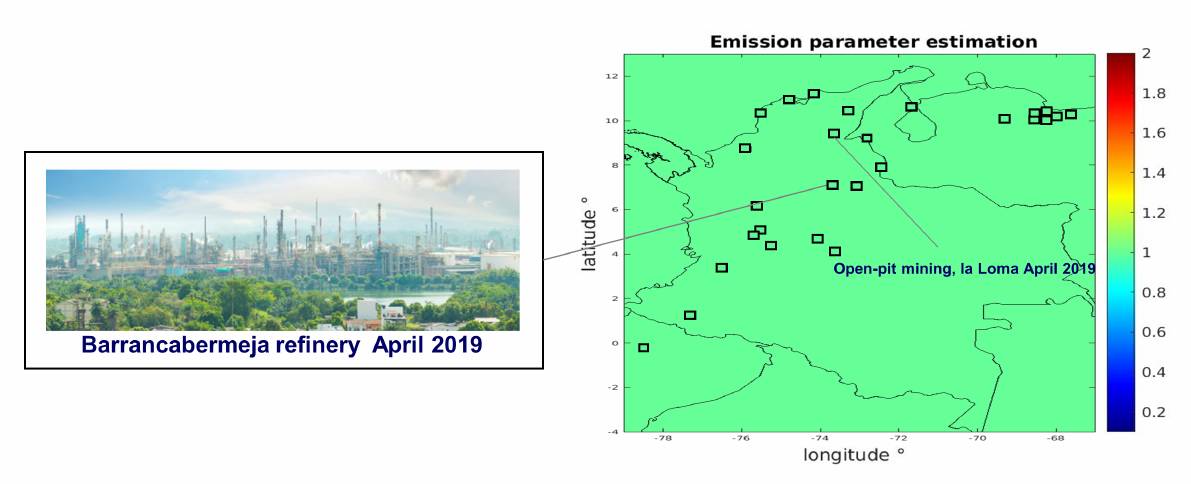
Figure 6. Locations selected for emission parameter adjustment via 4DEnVar data assimilation. The 27 locations indicated in the ( right ) panel, corresponding primarily to large urban centres, were chosen for parameter adjustment based on the magnitude of the differences observed in Figure 5. ( Left ) Location of Colombia’s largest oil refinery (near the city of Barrancabermeja). The Drummond open-pit coal mine, a non-urban site whose emissions were poorly represented by the default emissions